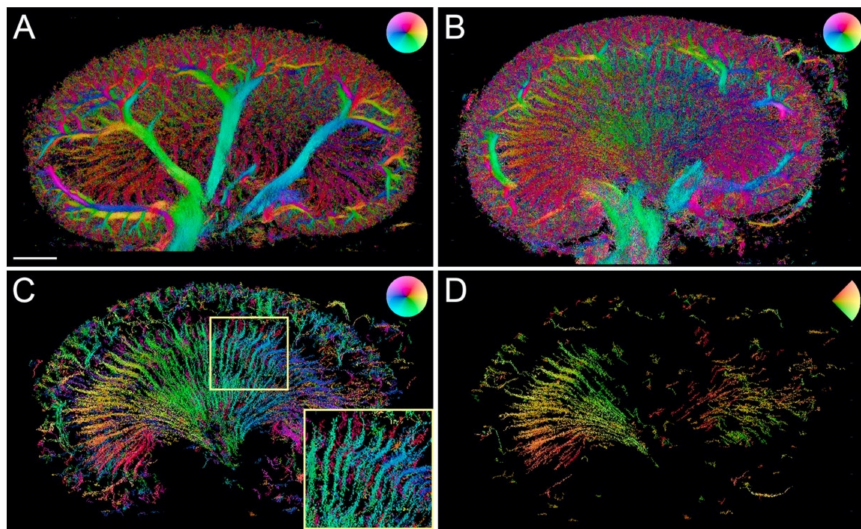
Figure 3. Super-resolution microbubble track maps. ( A ) Unfiltered microbubble track map. The color of the wheel indicates microbubble flow direction, and the color brightness indicates MB flow velocity. The image shows the opposite flow of the paired arteries and veins of the renal vascular tree. ( B ) Without filtering, this velocity map (from another rat) contains a high number of tracks (343,939). ( C ) The microbubble track map from ( B ) filtered to increase the robustness of the included tracks and highlight the long straight vasa recta, thereby allowing a distinction between the descending (green / blue) and ascending (red) vasa recta (insert). ( D ) Another way to filter these maps is by direction. This image is filtered to show microbubbles with a direction going from left to right, leaving the descending vasa recta visible on the left side of the medulla, and the ascending visible on the right side. Scale bar: 2